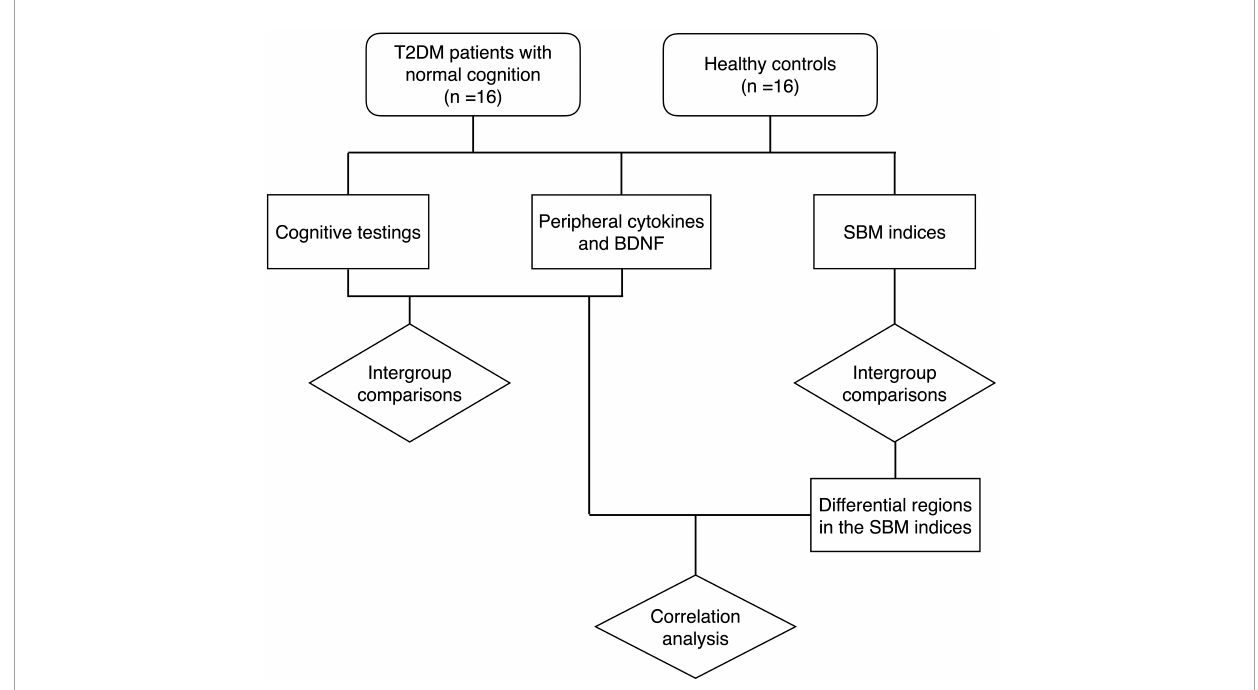
FIGURE1 The flow chart of the study. T2DM, type 2 diabetes mellitus group; BDNF, brain-derived neurotrophic factor; SBM, surface-based morphometry.